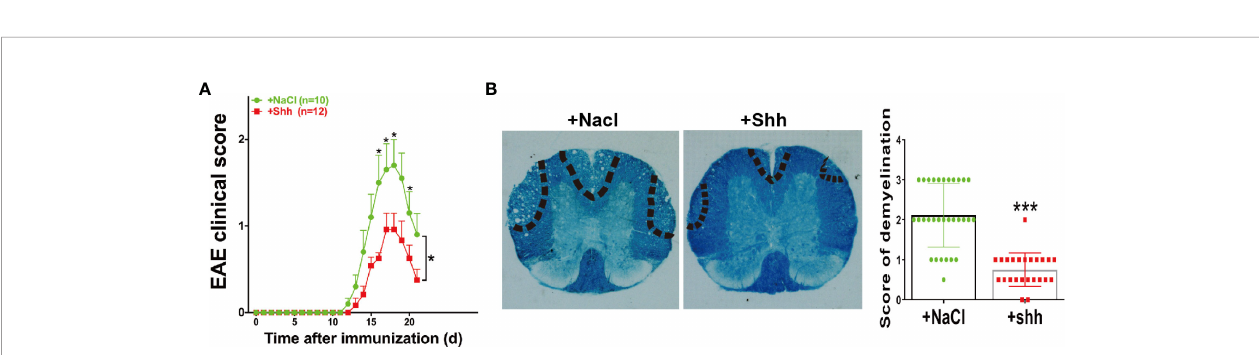
FIGURE 5 | The effect of shh on the progress of EAE. (A) Shh protein treatment was applied on the onset stage of EAE and the clinical score was observed across the progress of EAE. Data are shown as mean ± SEM. (B) LFB staining was used to study the demyelination of the spinal cord sections. The sections were obtained on the remission stage of EAE (images are representative of 4-5 mice in each group). The bar denotes 200 m m. Data (n = 3-5 mice in each group, and 5 – 6 sections from each mouse were used for LFB staining and scoring) are shown as mean ± SD. (* P < 0.05, *** P <